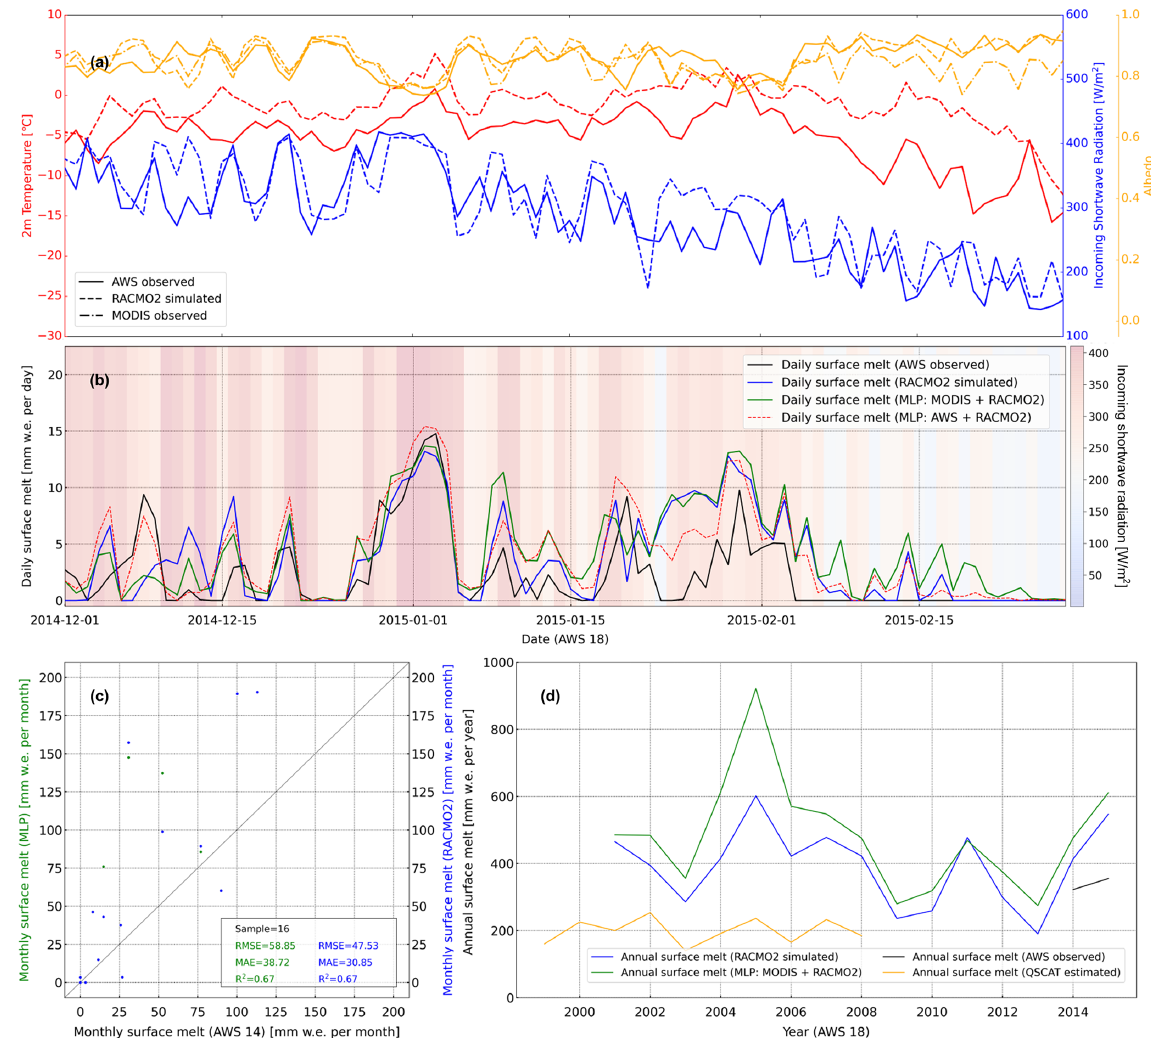
Figure 11. The same as Fig. 9 but for AWS 18 during the austral summer 2014–2015 in (a) and (b)